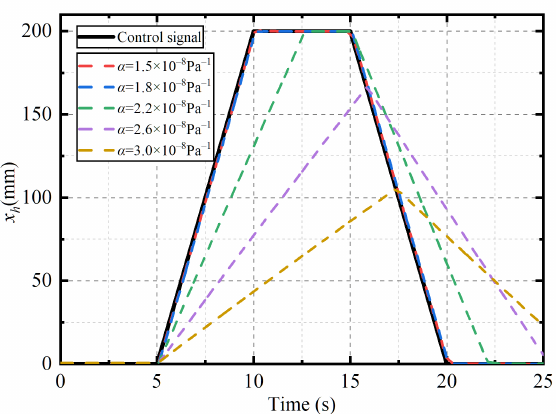
Figure 13. Displacement output, x h , at different viscosity-pressure index of hydraulic oil, α , when depth is 11 km.